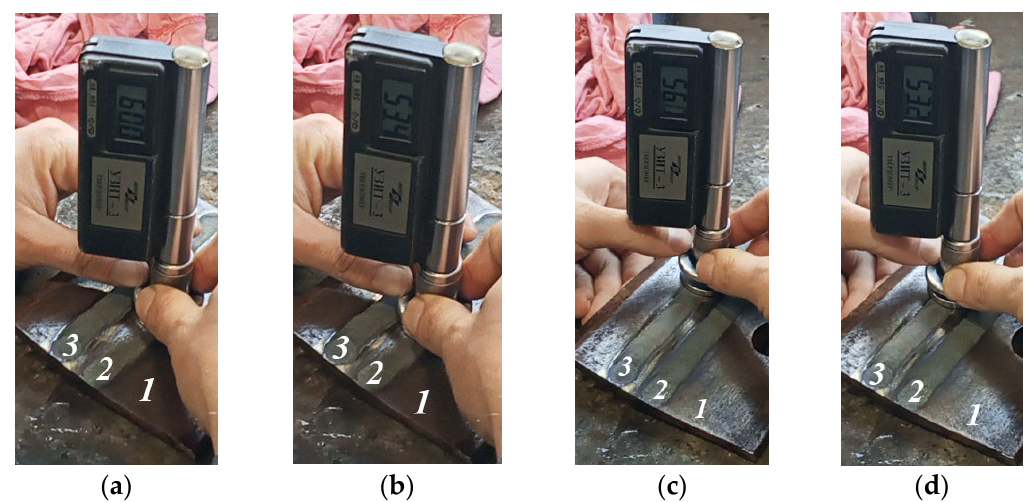
Figure 3. Operational hardness test: ( a , b ) surface hardened without additional treatments; ( c , d ) surface preliminarily cleaned from surface marks (rust, scratches, etc.) using a grinding machine before hardening, 1—non-hardened surface; 2—surface hardened without additional treatments; 3—surface preliminarily cleaned from surface marks (rust, scratches, etc.) using a grinding machine before hardening.